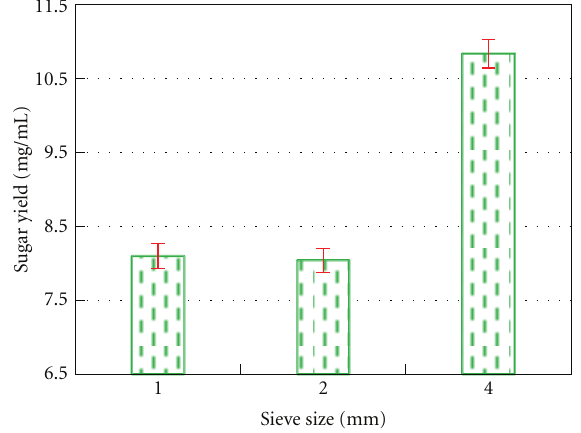
Figure 12: E ff ects of sieve size on sugar yield.